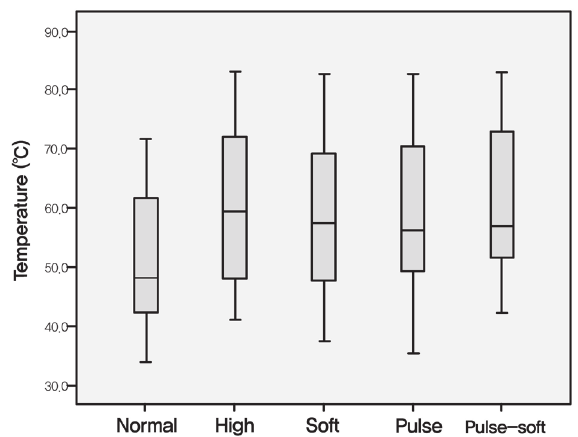
Figure 2- Mean peak polymerization temperature (°C) of composite resin specimens at the selected spots according to the light curing modes of light emitting diode light curing unit